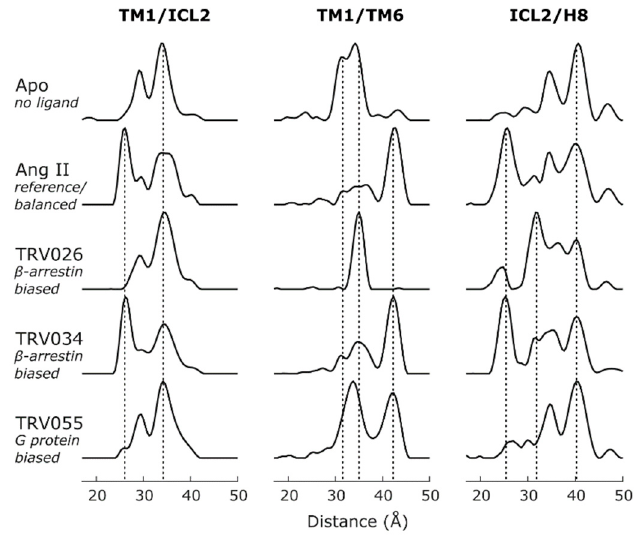
Figure 2. GPCR conformational heterogeneity. Distance distributions between spin labels attached to the indicated receptor segments reveal conformational heterogeneity of AT1R, which is differentially modulated by ligands of distinct function (in italics). Ang II is the endogenous, balanced agonist, while TRV026/034 and TRV055 represent β -arrestin and G protein-biased ligands, respectively. Dotted lines indicate main conformations. For this study, the cytoplasmic ends of AT1R TMs were spin labeled using IDSL (cf. [38] for the full dataset).